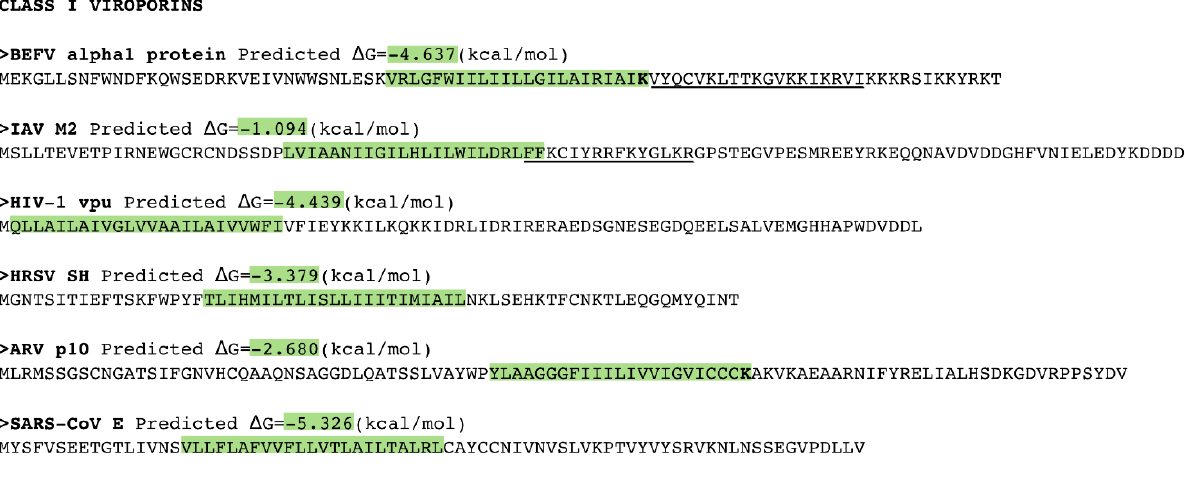
Figure 1. Sequence analysis of Class I and Class II viroporins. Sequence, in FASTA format, of the Class I viroporins included in this review. The putative transmembrane (TM) segments found by the ∆ G Prediction Server v1.0 [13] and their predicted ∆ G values (kcal/mol) are highlighted in green (indicating a negative ∆ G value). The Lys residues within the TM segments are displayed in bold. Amphipathic TM flanking regions are underlined. BEFV Bovine ephemeral fever virus, IAV Influenza A virus, HIV Human immunodeficiency virus, HRSV Human respiratory syncytial virus, ARV Avian reovirus, SARS-CoV Severe acute respiratory syndrome